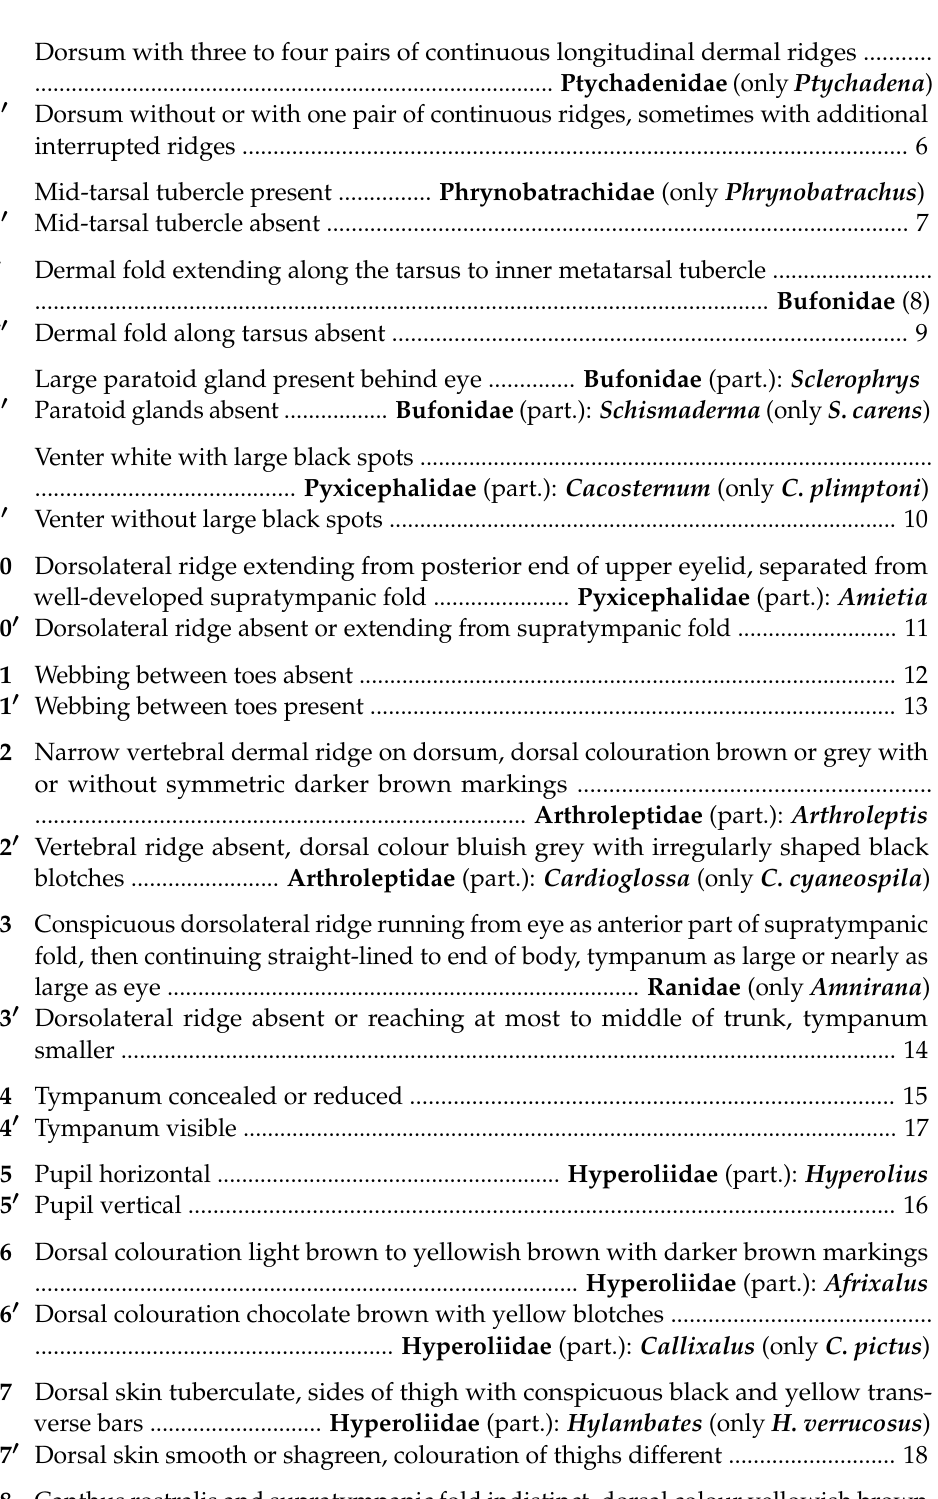
16 (cid:48) Dorsal colouration chocolate brown with yellow blotches .......................................... 17 Dorsal skin tuberculate, sides of thigh with conspicuous black and yellow trans- 17 (cid:48) Dorsal skin smooth or shagreen, colouration of thighs different ........................... 18 18 Canthus rostralis and supratympanic fold indistinct, dorsal colour yellowish brown